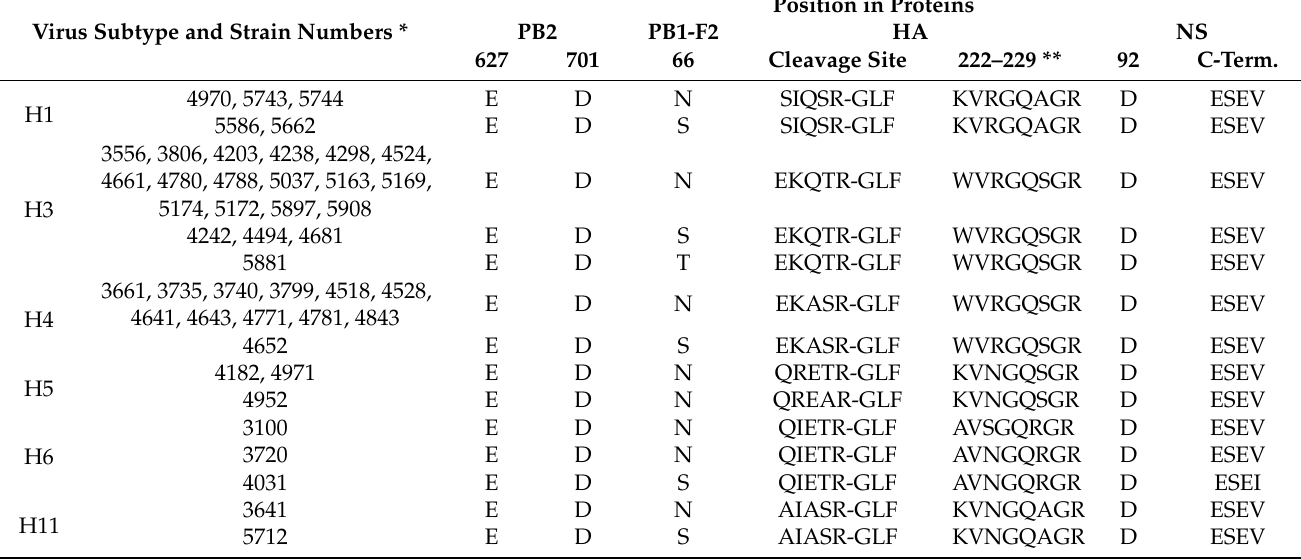
Table 1. Amino acids associated with increased pathogenicity of IAVs isolated in